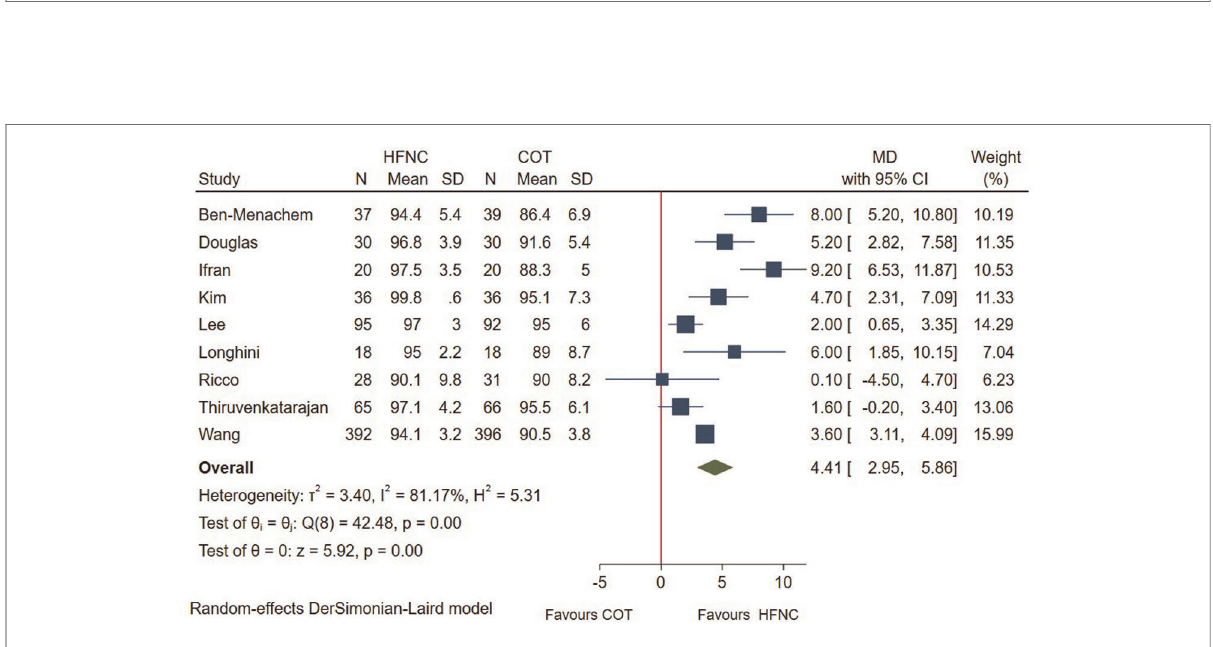
FIGURE 2 Forest plot comparing hypoxemia during the procedure in HFNC versus COT. HFNC, high fl ow nasal cannula; COT, conventional oxygen therapy; RR, risk ratio.